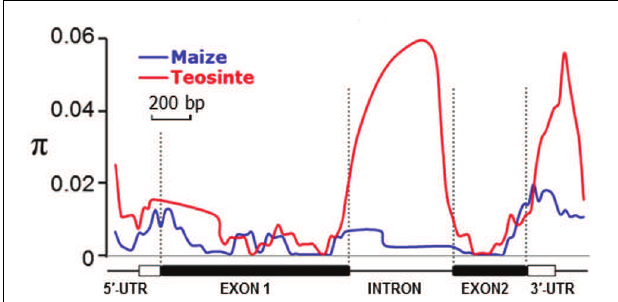
FIGURE 1 | Nucleotide diversity ( π ) of ZmARF31 in maize and teosinte. A total of 331 maize inbreds and eight teosinte lines were used in sliding window analysis, with window length of 100 sites and step size of 25